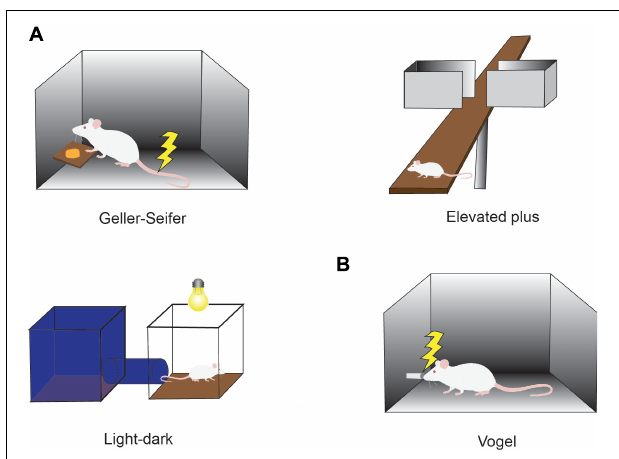
FIGURE 1 | Conflict tasks used to quantify the effects of anxiolytics. (A) Conflict task used in preclinical studies of anxiolytics. In the Geller-Seifer conflict test (left), the rat was trained to push the lever under conflict conditions in which reward could be obtained by pushing the lever, but it caused electric shock at the same time. The elevated plus-maze test (right) and the light-dark box test (bottom left) are often used because they are simple and can examine the behaviors under conflict situations between the desire to approach a new condition and the need to avoid anxiety factors such as high place and strong light. The effects of anxiolytics have been measured by observing the behaviors in these tasks. (B) Vogel conflict test. Changes in drinking frequency were measured in the Vogel conflict test. Rats frequently lick when they do not receive an electric shock, but the frequency decreases with an increase in the frequency of electric shock. Recovery of drinking frequency was observed depending on the concentration of benzodiazepine (Chlordiazepoxide) even under the condition that an electric shock was simultaneously